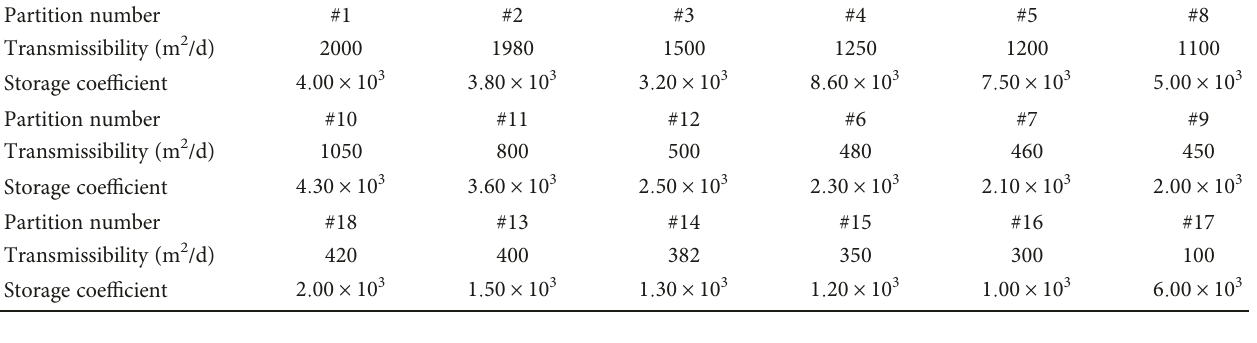
Table 2: Material parameters for di ff erent partition elements in the Su-Xi-Chang area.